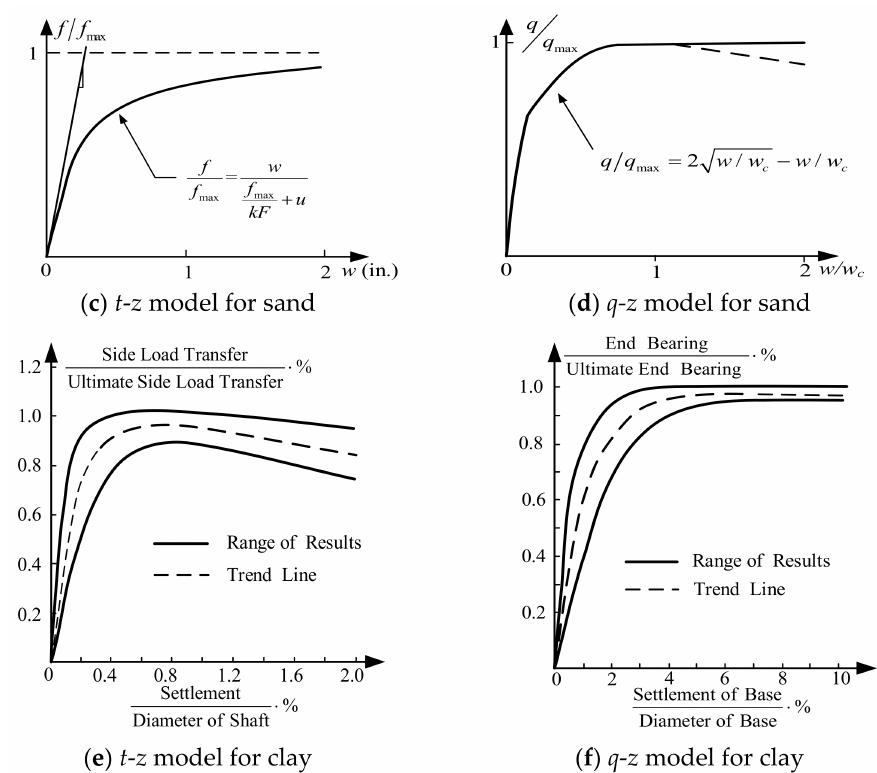
Figure 5. Pile-soil interaction